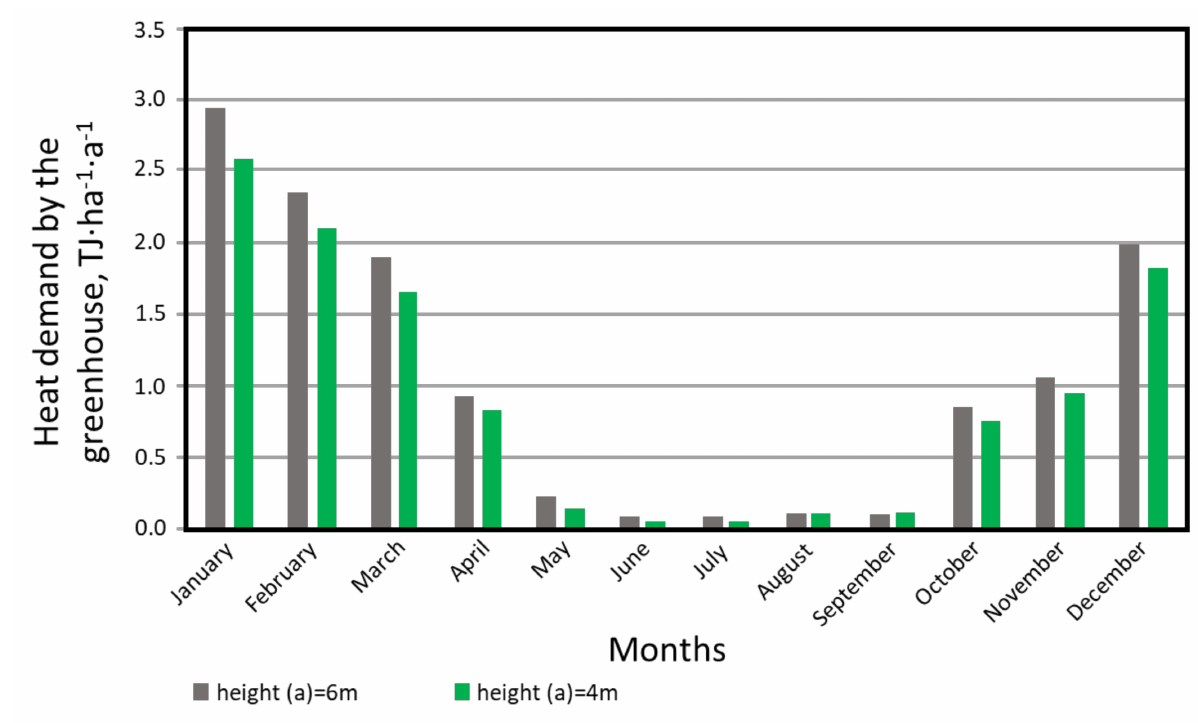
Figure 5. Heat demand of a greenhouse with a wall height of 6 or 4 m.